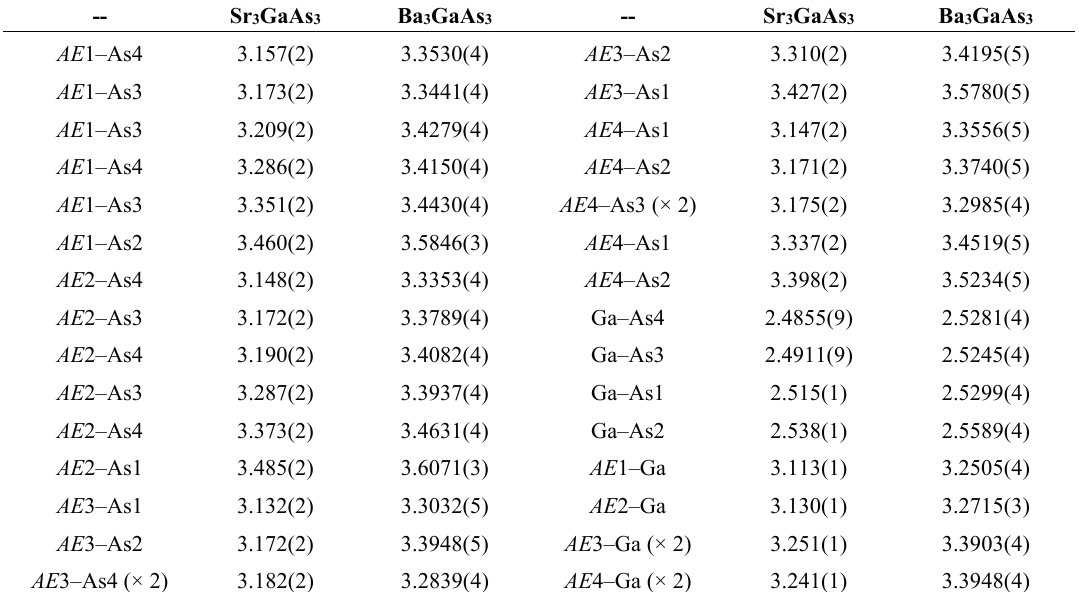
Table 5. Selected interatomic distances (Å) in AE 3 GaAs 3 ( AE = Sr, Ba).